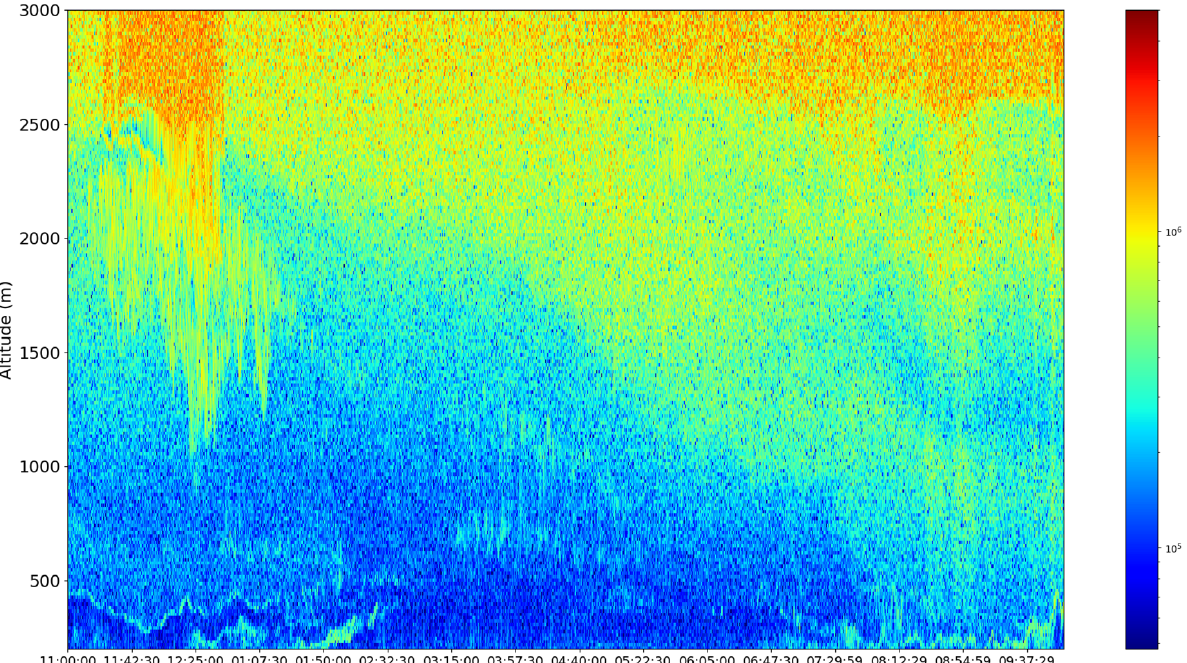
i, Romania, 22 December ,